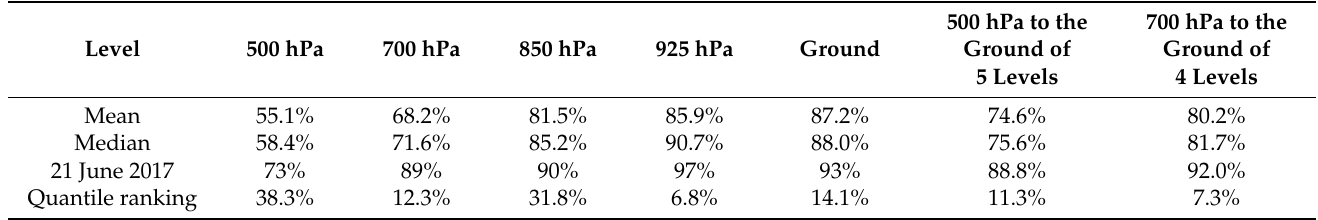
Table 1. Comparison of relative humidity (%) at 2000 LST on 21 June 2017 and historical (2011–2020) relative humidity at 2000 LST in June based on the YJ